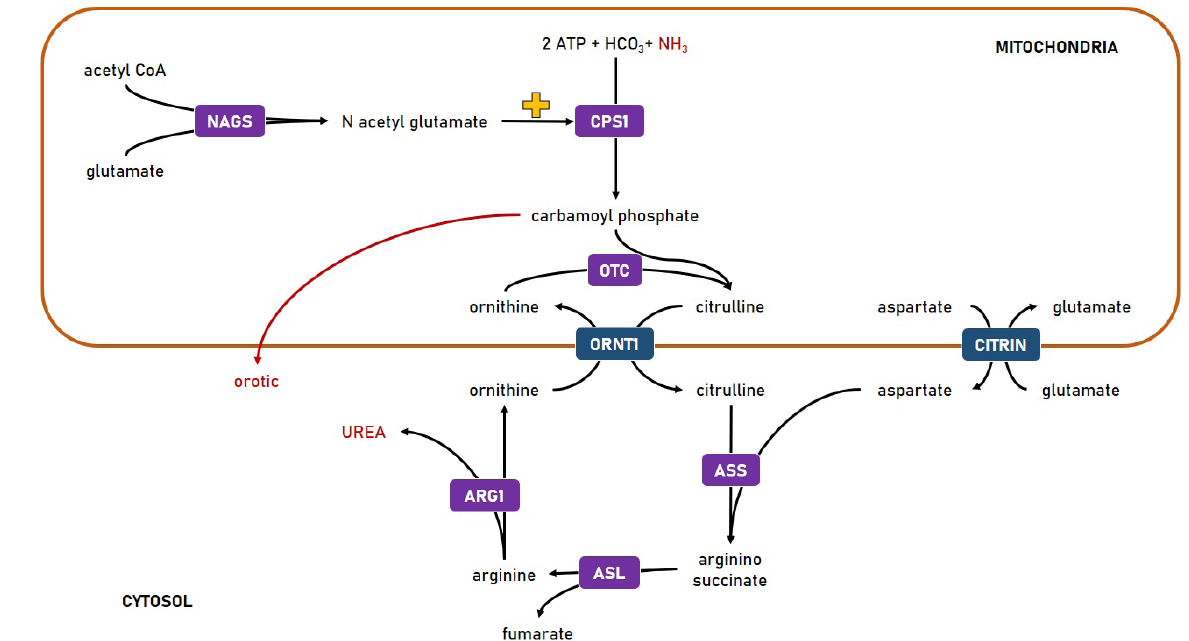
Figure 1. The Urea Cycle. ASL: Argininosuccinic lyase. ASS: Argininosuccinic synthetase. ARG1: Arginase 1. ATP: adenosine triphosphate. CITRIN: aspartate/glutamate transporter. CPS1: Carbamoyl phosphate synthetase 1. NAGS: N-acetylglutamate synthetase. ORNT1: Mitochondrial ornithine/ citrulline. OTC: Ornithine